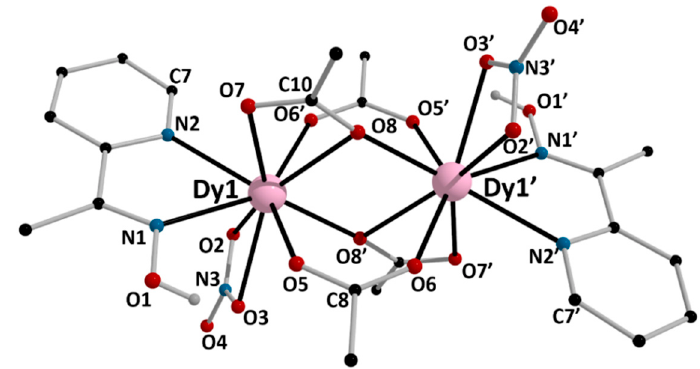
Figure 4. Partially labeled plot of the structure of the dinuclear molecule [Dy 2 (O 2 CMe) 4 (NO 3 ) 2 (mepaoH) 2 ] that is present in the crystal of 5 . Symmetry operation: (‘) = – x +2, − y +1, – z +2. Table 1. Selected interatomic distances (Å) and angles (°) for complexes 1 and 5 . a.